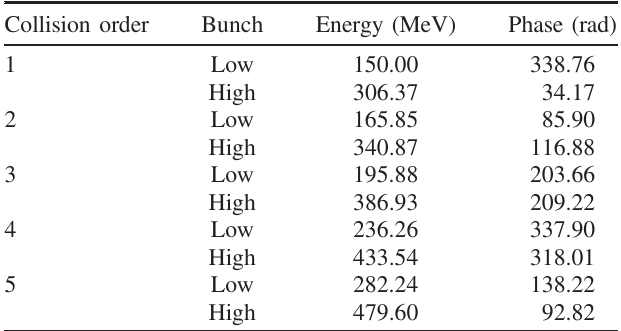
TABLE II. Some physical parameters of low-energy and high- energy bunches at the entrance of collision